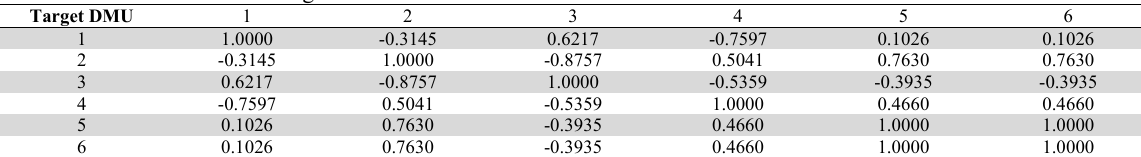
Correlation matrix for six nursing homes Target DMU